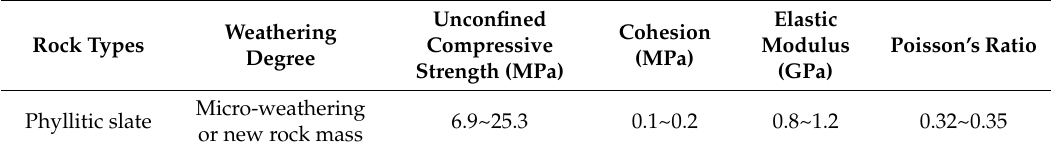
Figure 6. Rock mechanics test: ( a ) laboratory rock test; ( b ) point load test. Table 1. Results of rock mechanics test.